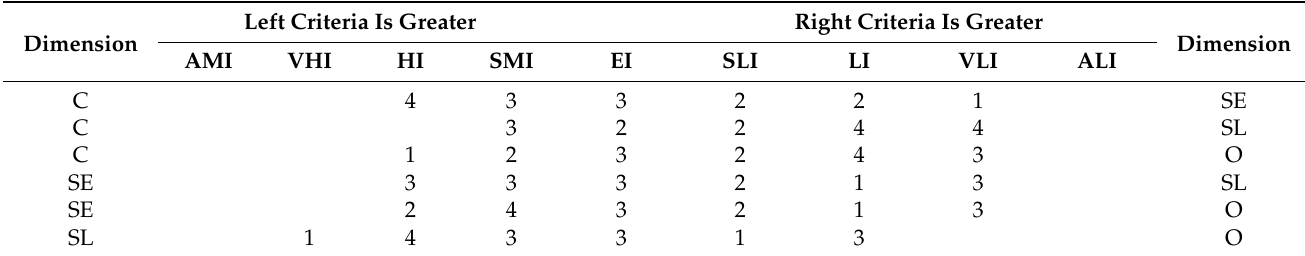
Table 7. The pairwise comparison matrix of the AHP-SF model.